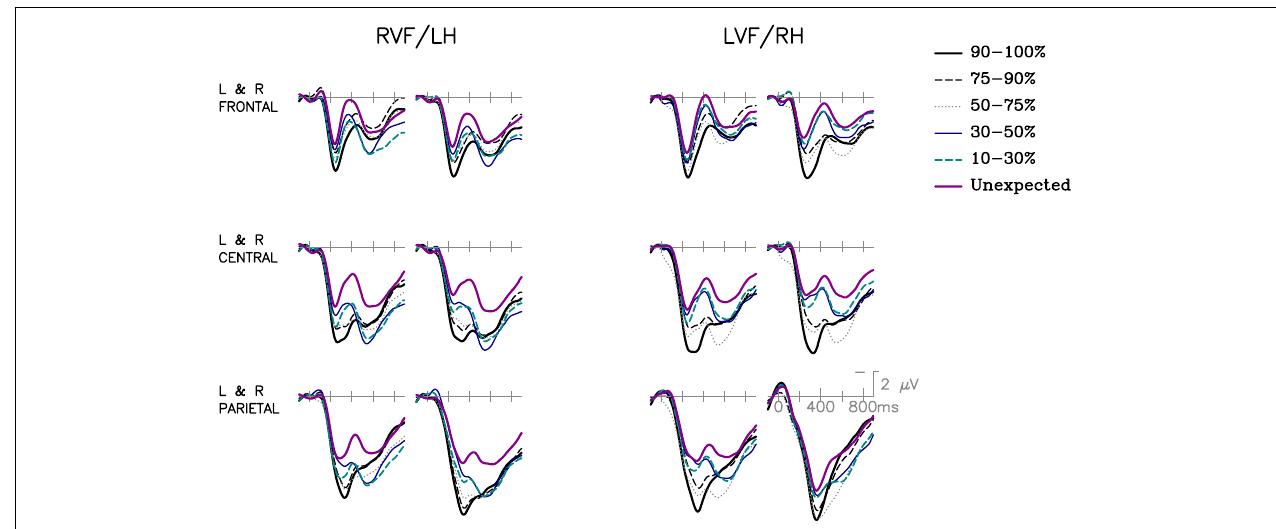
FIGURE 4 |Traditional grand average ERPs for the 6 cloze probability bins described in the Method section at Left and Right Frontal, Central, and Parietal sites (LDFr, RDFr, LMCe, RMCe, LDPa,